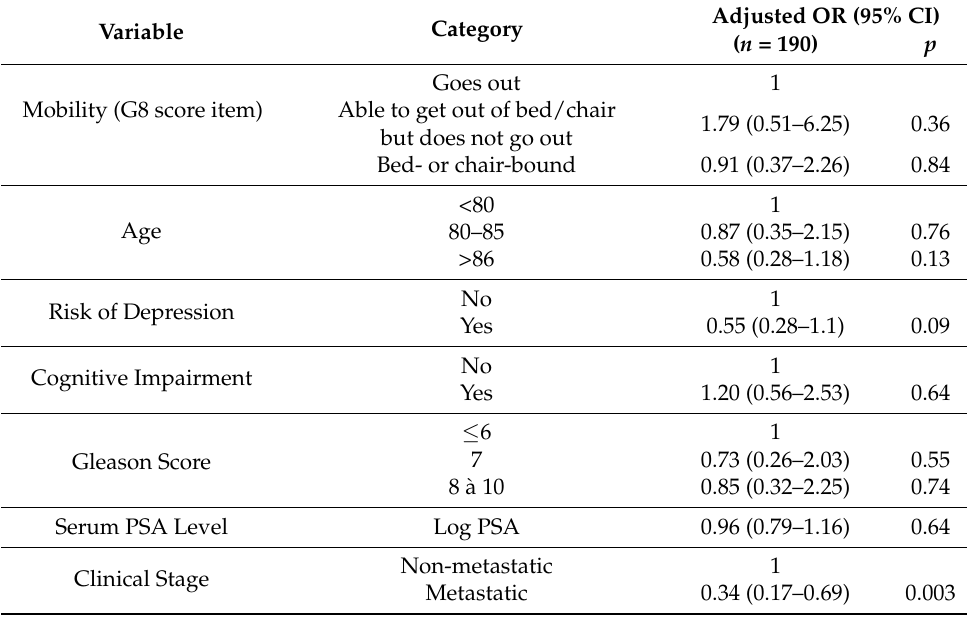
Table 1. Multivariable analysis of factors associated with